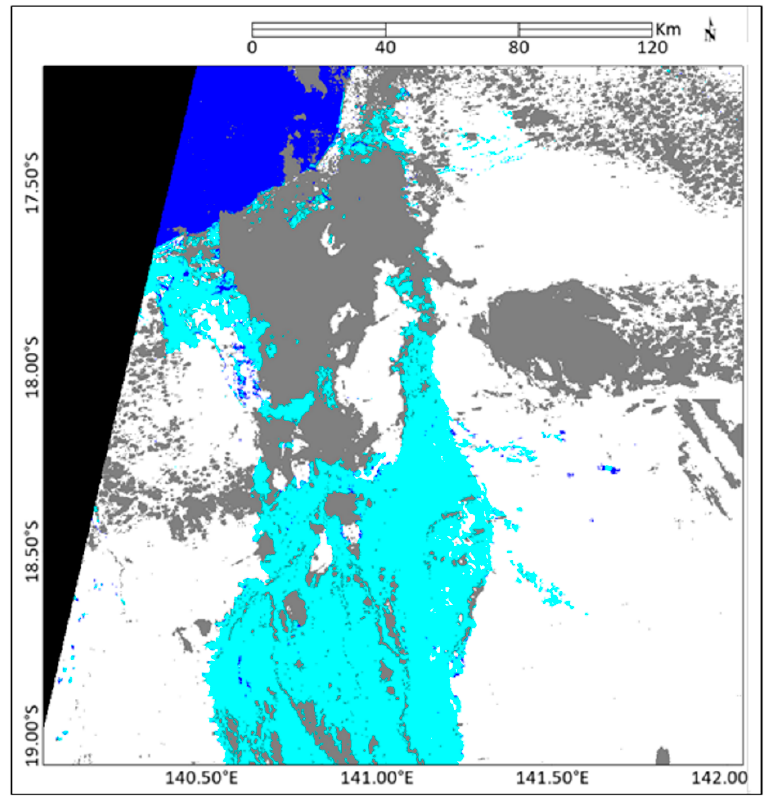
Figure 6. BFCA-derived flooded area map for the EMSR342 test case (Queensland flood). Cyan: flooded; blue: permanent water; grey: masked (cloudy) pixels; white: non-flooded; black: unclassified.